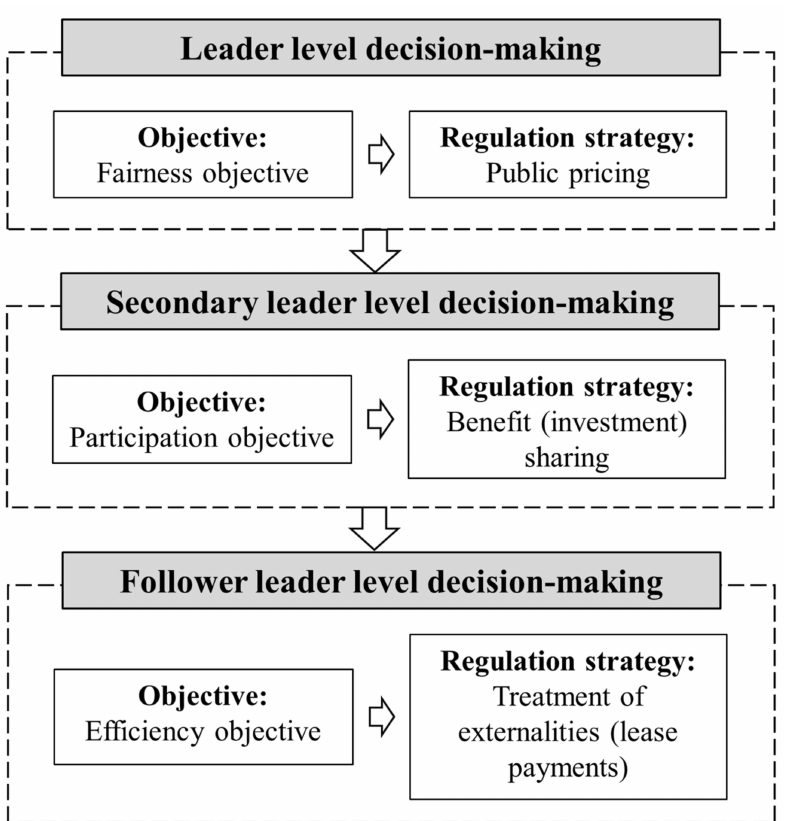
Figure 1. The framework of multidimensional regulatory